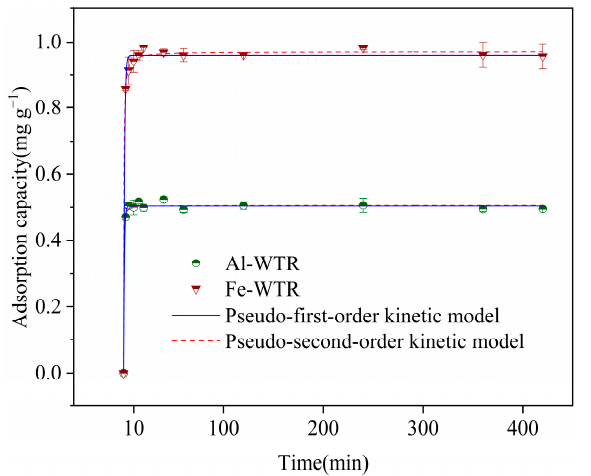
Figure 1. Kinetics of adsorption of Tl(I) by Fe-WTR and Al-WTR. Table 2. Adsorption kinetic model parameters of Fe-WTR and Al-WTR for Tl(I).